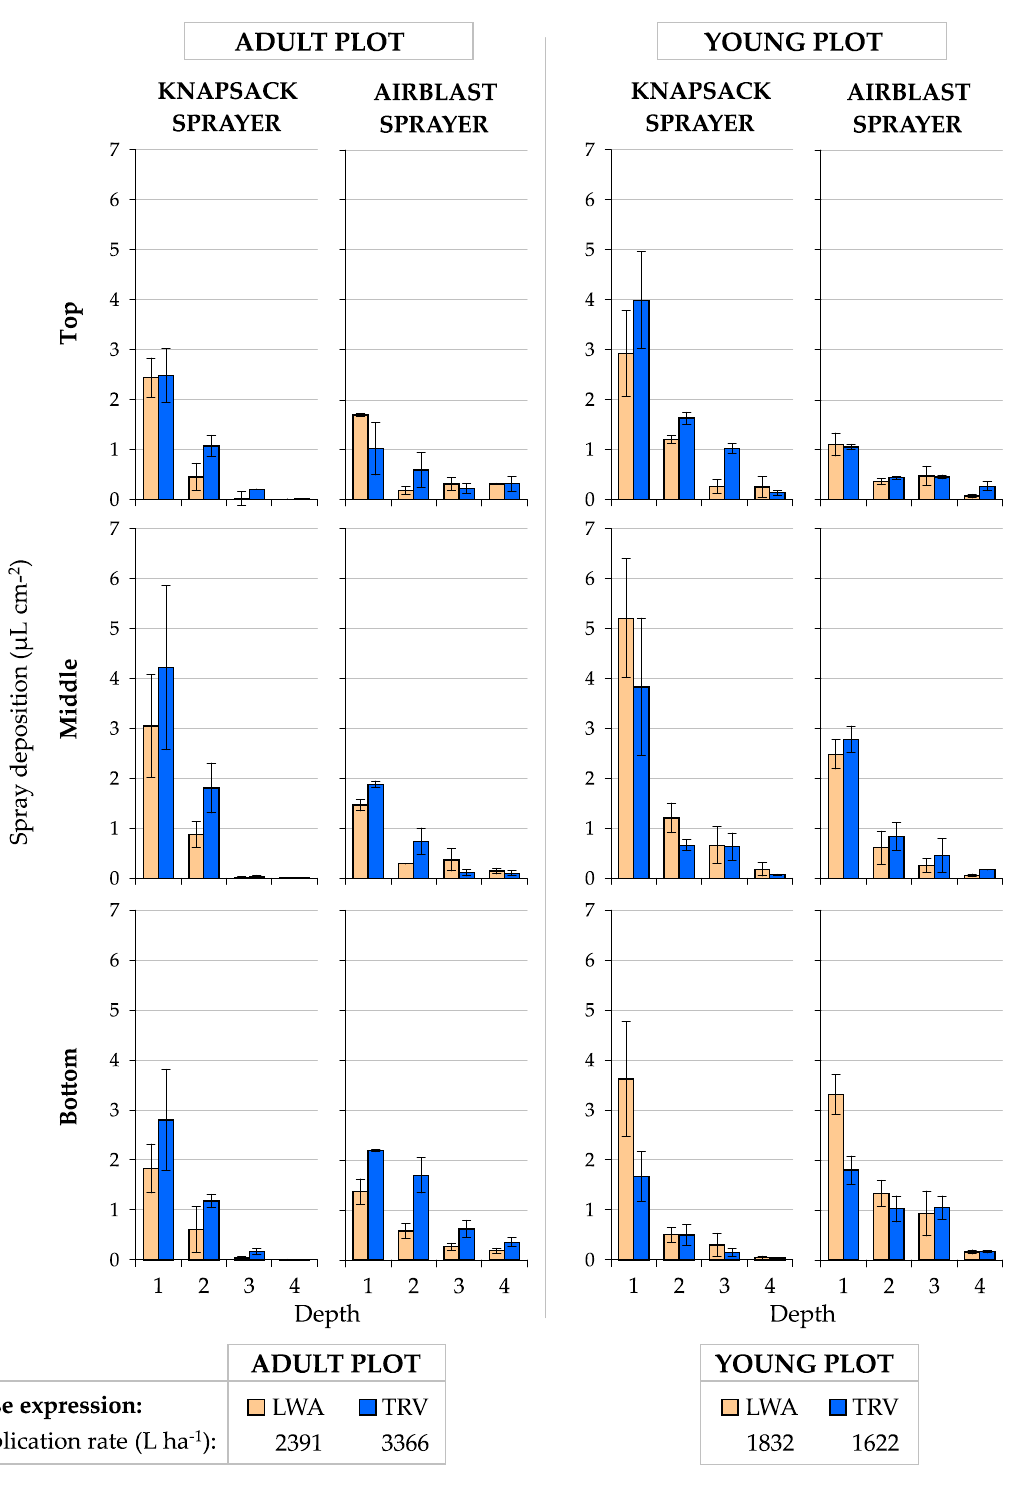
Figure A2. Spray deposition (mean (s.e.), μ L cm − 2 ) in the different areas of the tree canopy (height and depth) depending on the application sprayer and the dose expression in the adult and young plots.